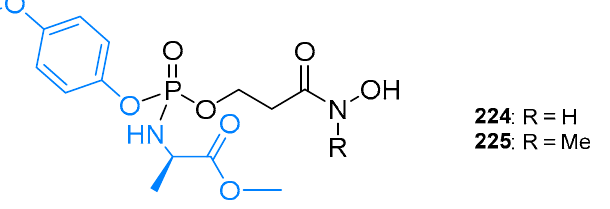
Figure 42. Structures of aryl phosphoramidate prodrugs of fosmidomycin ( 224 ) and FR900098 ( 225